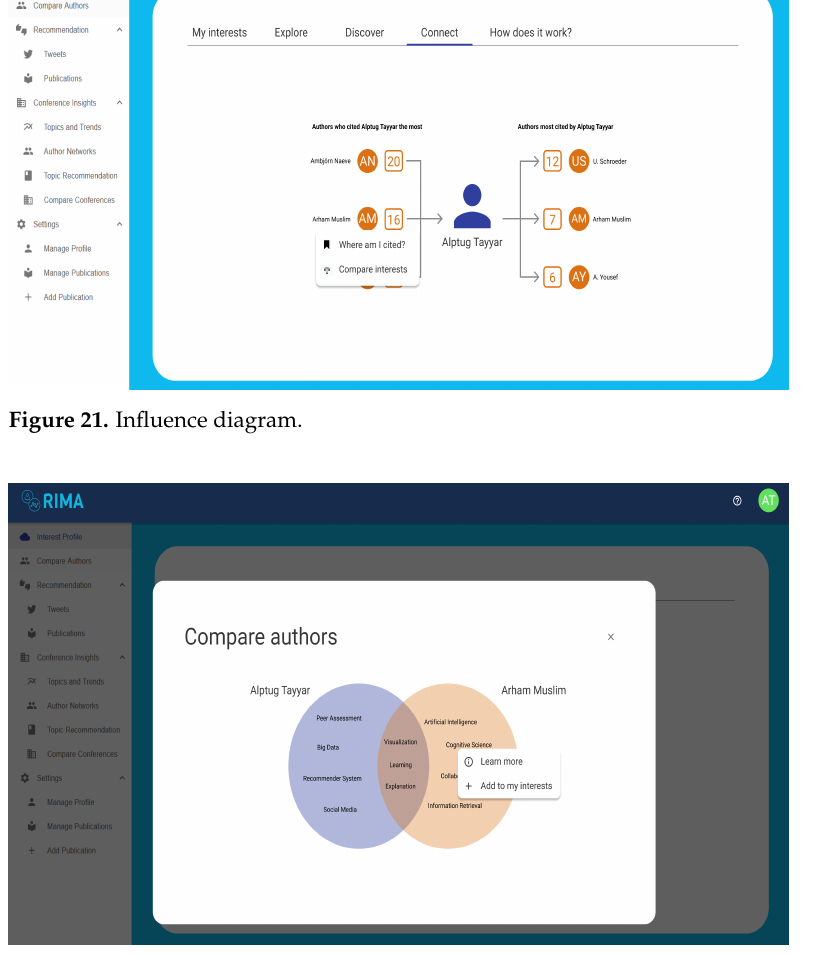
Figure 22. Compare user interest profiles.